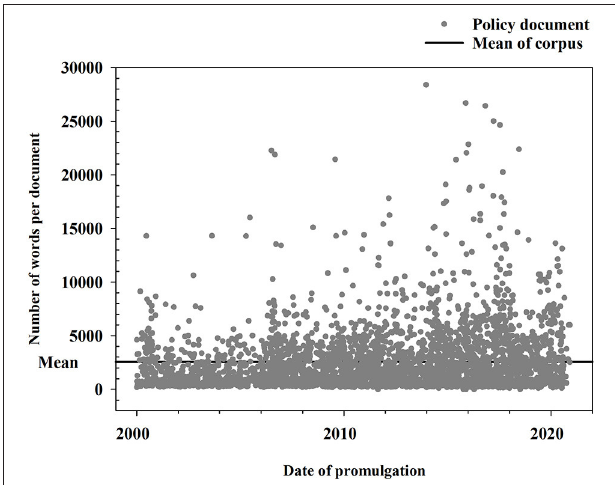
FIGURE 2 | Descriptive statistics of policy